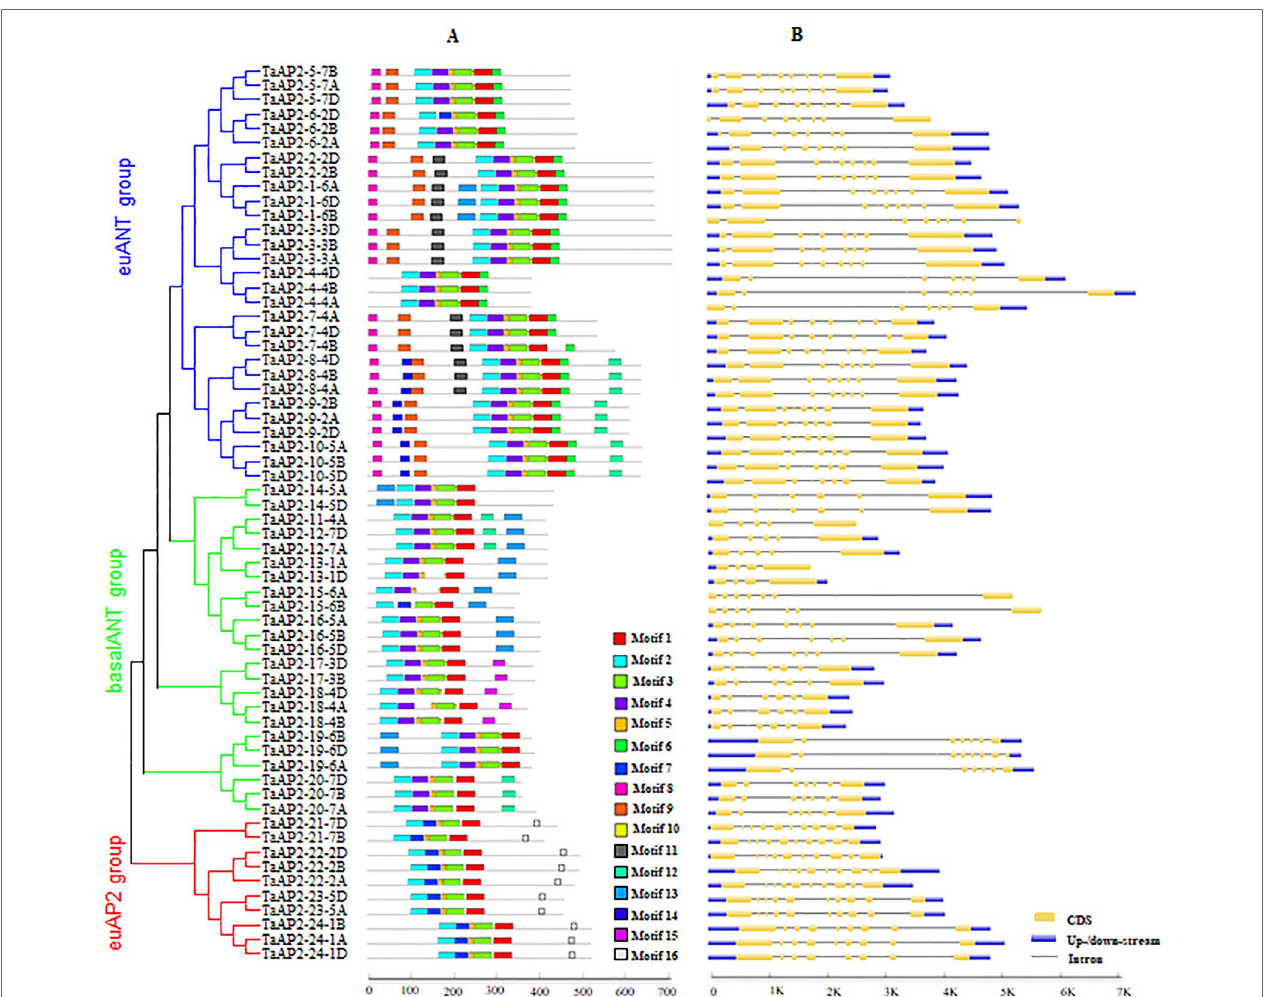
FIGURE 2 | Motif composition and exon–intron structures of TaAP2s. (A) Conserved motifs organization of TaAP2 proteins. Color blocks represent the position of motifs on corresponding proteins. Block sizes indicate the lengths of motifs. Gray lines represent non-conserved sequences. The relative position of each motif can be determined using the scale below. (B) Exon–intron structures of TaAP2 genes. Exons are represented by yellow boxes and introns were denoted by blank lines. The lengths of exons and introns could be estimated using the scale